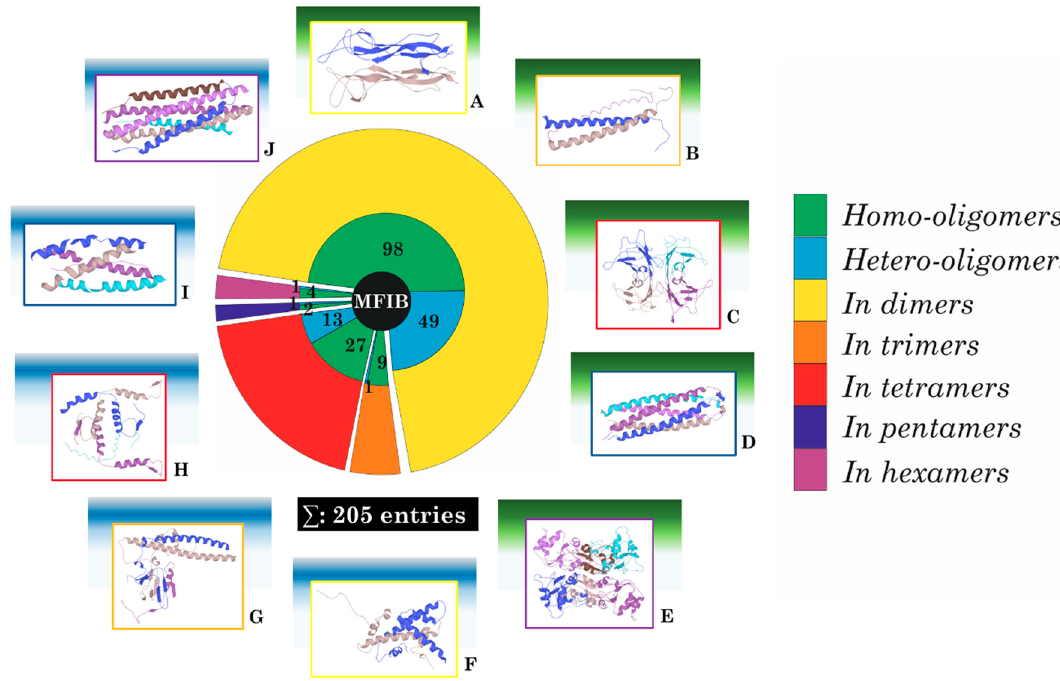
Figure 1. Oligomeric states in the MFIB database with example complexes. ( A : 1BET, nerve growth factor ( Mus musculus ); B : 1AQ5, assembly domain of cartilage oligomeric matrix protein ( Gallus gallus ); C : 1GKE, Transthyretin ( Rattus norvegicus ); D : 1MZ9, assembly domain of cartilage oligomeric matrix protein ( Mus musculus ); E : 1NPK, nucleoside diphosphate kinase ( Dictyostelium discoideum ); F : 5GT0, H2A-H2B histone dimer, containing histone variants H2A type 1-A and H2B type 1-J ( Homo sapiens ); G : 2AZE, Rb C-terminal domain bound to an E2F1-DP1 heterodimer ( Homo sapiens ); H : 2NB1, p63/p73 hetero-tetramerization domain ( Homo sapiens ); I : 1VZJ, The synaptic acetylcholinesterase tetramer assembled around a polyproline-II helix ( Homo sapiens ); J : 1G2C, respiratory syncytial virus fusion protein core ( Homo sapiens ).